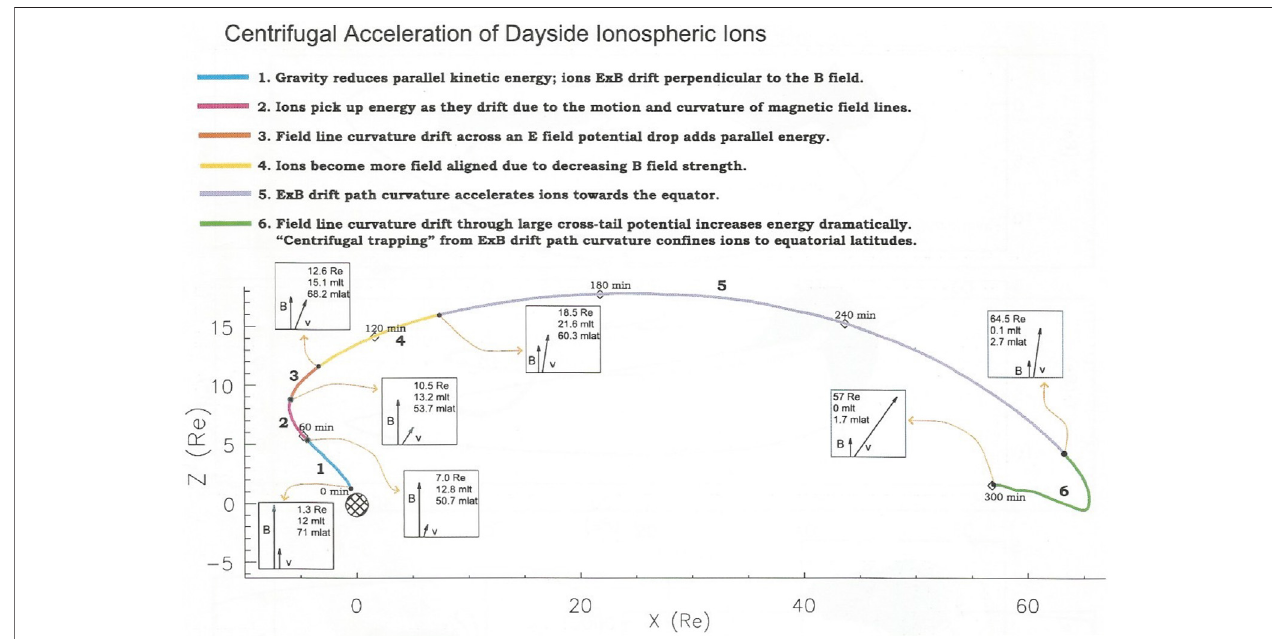
FIGURE5| Thetrajectoryofapolarwindionmoving fromthedaysideionosphereoutthroughthepolarcapandtaillobestotheplasmasheetandits energization.